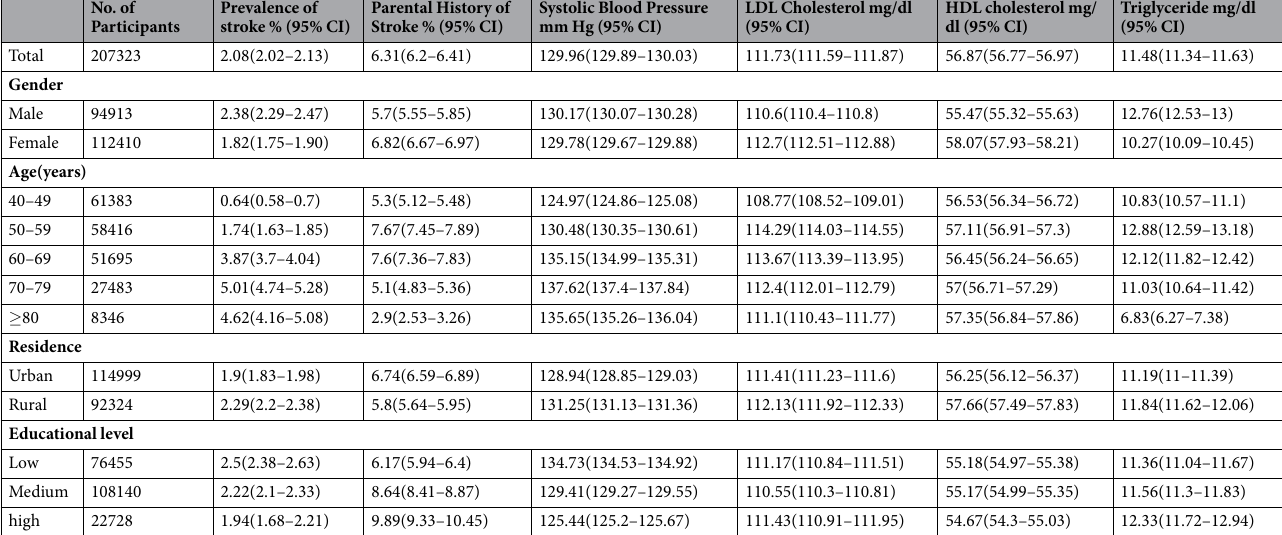
Table 2. Standardized Prevalence of stroke and Vascular Risk Factors. * Abbreviation: HDL denotes high- density lipoprotein; LDL denotes low-density lipoprotein. To convert low-density lipoprotein and high-density lipoprotein cholesterol to millimoles per liter, multiply by 0.0259. To convert triglycerides to millimoles per liter, multiply by 0.0113.